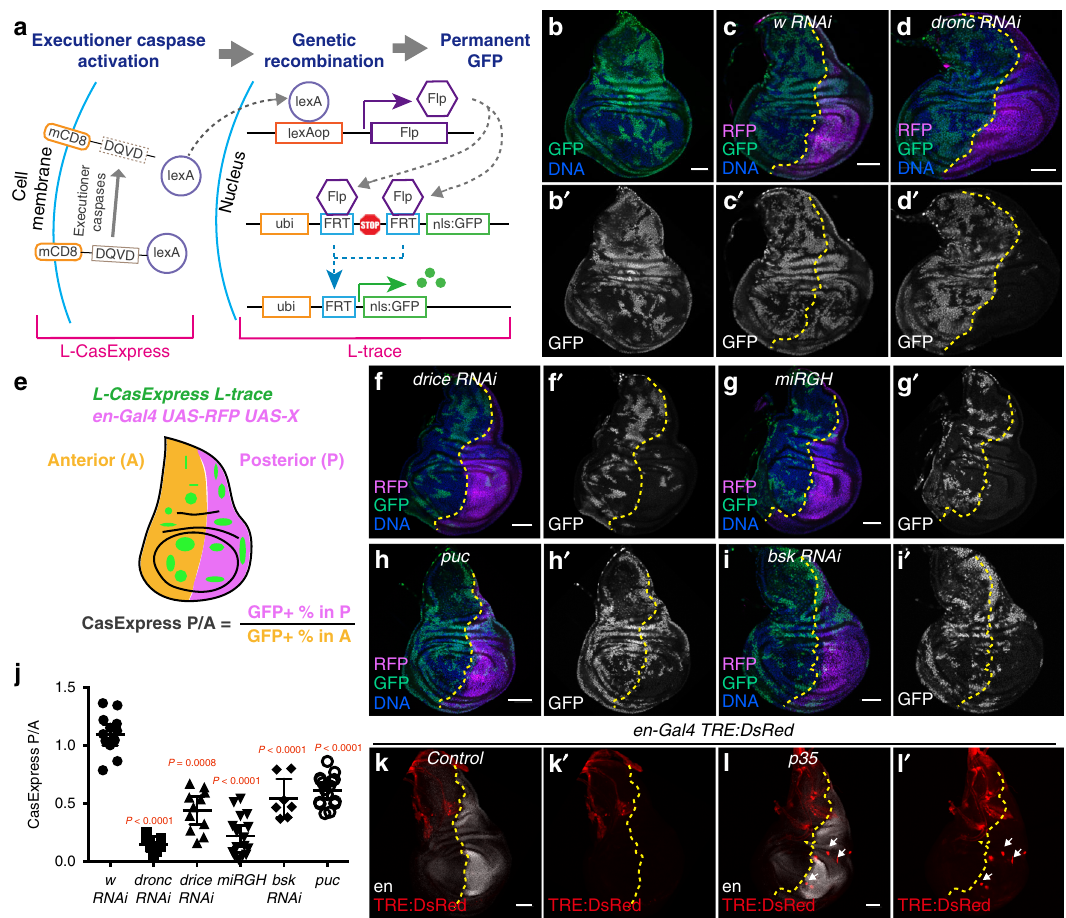
Fig. 3 Developmental CasExpress activation depends on apoptosis-inducing signals. ( a ) A schematic of L-CasExpress and L-trace. ( b ) L-CasExpress; L- trace wing disc. GFP labels cells that survive executioner caspase activation. ( c , d ) Discs expressing enGal4 , UAS-RFP , L-CasExpress , L-trace , and UAS-w RNAi ( c ) or UAS-dronc RNAi ( d ). ( e ) A schematic of the method for quantifying the effect of a genetic manipulation on survival from executioner caspase activation. A transgene (X) is expressed in the posterior compartment of the wing disc under en-Gal4 , and survival from executioner caspase activation in the whole disc is monitored by L-CasExpress. The effect of expression of X on CasExpress activation is measured by the ratio of the percentage of GFP + cells in the posterior compartment to that in the anterior compartment. ( f – i ) The effect of inhibiting apoptosis or JNK pathway on cell survival. Wing discs shown in the images expressed L-CasExpress , L-trace , en-Gal4 , UAS-RFP , and UAS-drice RNAi ( f ), UAS-miRGH ( g ), UAS-puc ( h ), or UAS-bsk RNAi ( i ). ( j ) Quanti fi cation of CasExpress P/A ratio of the listed genotypes. n = 14 ( w RNAi ), 7 ( dronc RNAi ), 11 ( drice RNAi ), 16 ( miRGH ), 7 ( bsk RNAi ), 16 ( puc ). n is the number of biological independent samples used for quanti fi cation. The data are presented as mean values± 95% con fi dence interval. Statistical signi fi cance was determined after the logarithm transformation using one-way ANOVA. The Tukey test was used to derive adjusted P -value for multiple comparisons. The P values compared to w RNAi are shown in the plot. Source data are provided as a Source Data fi le. ( k , l ) More cells with JNK activity were kept in the epithelium when execution of apoptosis was blocked (white arrows in l ). Trachea attached to the disc are also DsRed + and not affected by p35 expression. In all images, RFP marks UAS transgene expressing region. The yellow dotted lines mark the boundary between the anterior compartment and the posterior compartment. Scale bar is 50 μ